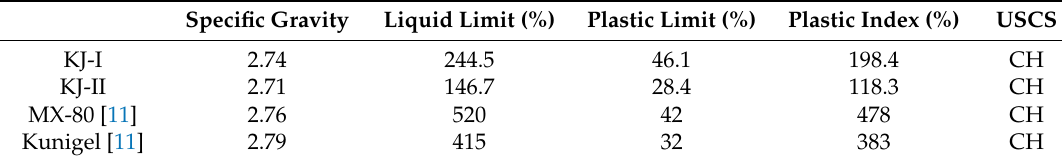
Table 2. Geotechnical properties of bentonites.